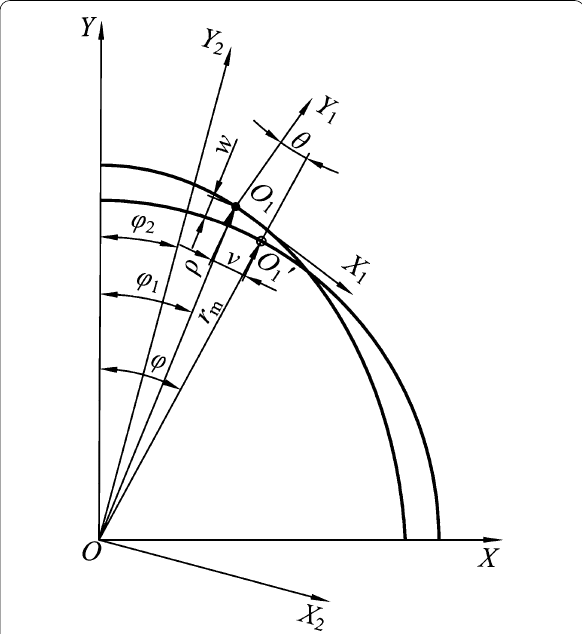
Figure 1 Schematic diagram of the positional relationship between cam, flexspline and circular